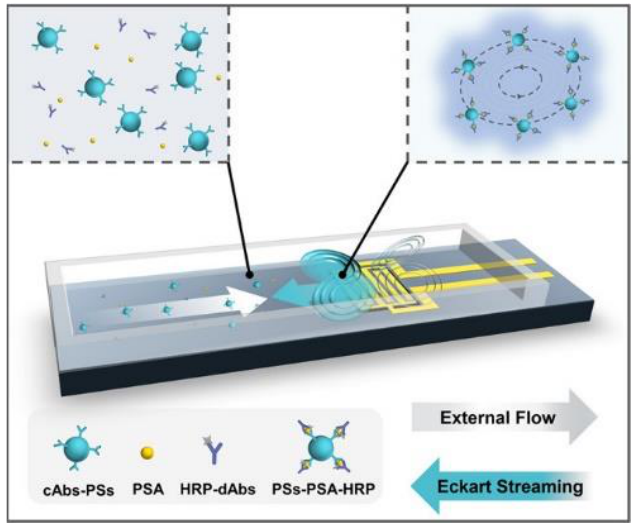
Figure 8. A simple view of an active micromixer device [73] , Copyright 2021, ACS Publications. (a) Acoustic Field-Driven Micromixers